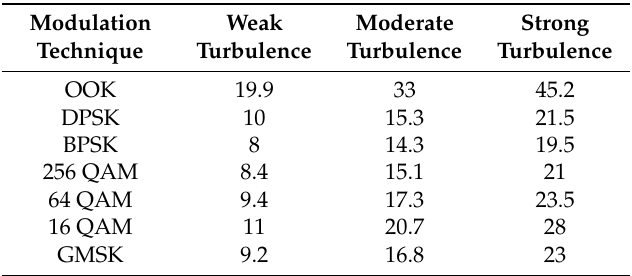
Figure 6. BER performance of different modulation formats without SDRT in a strong turbulence channel. Table 2. SNR values (in dB) for modulation techniques without SDRT at BER 10 − 8 for weak, moderate and strong regimes.